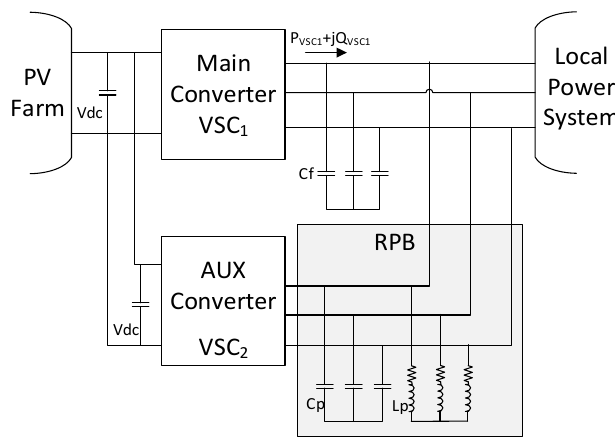
Figure 5. Circuit setup of PV–Grid system with Auxiliary converter and RBP [72].